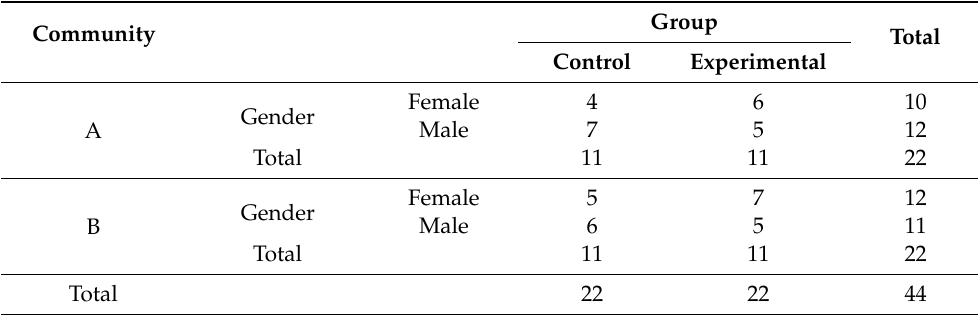
Table 2. Number of subjects by community, gender and group.